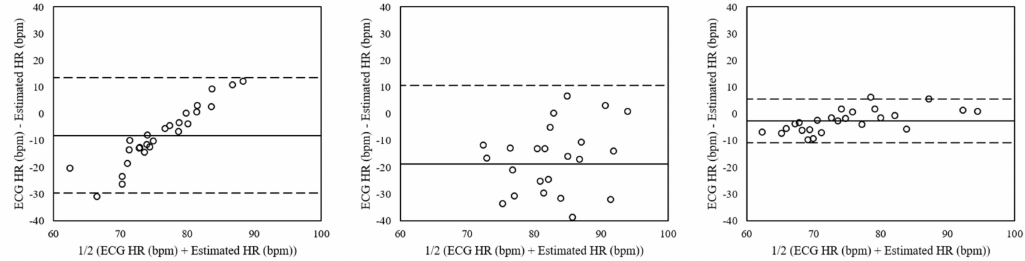
Figure 11. Bland–Altman plots of heart rates estimated from the dataset including the motion artifacts by facial expressions and voluntary head motions using peak detection ( Left ), FFT ( Mid ), and clustering ( Right ). The lines are the mean errors and 95%